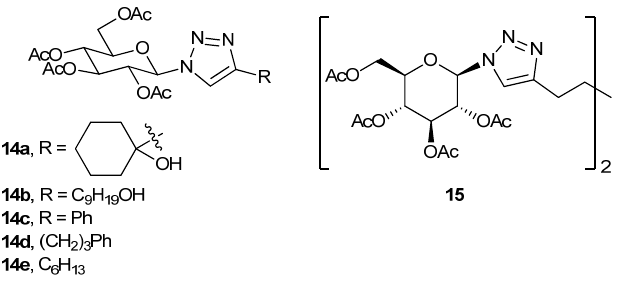
Figure 12. Glucosylated triazole derivatives.